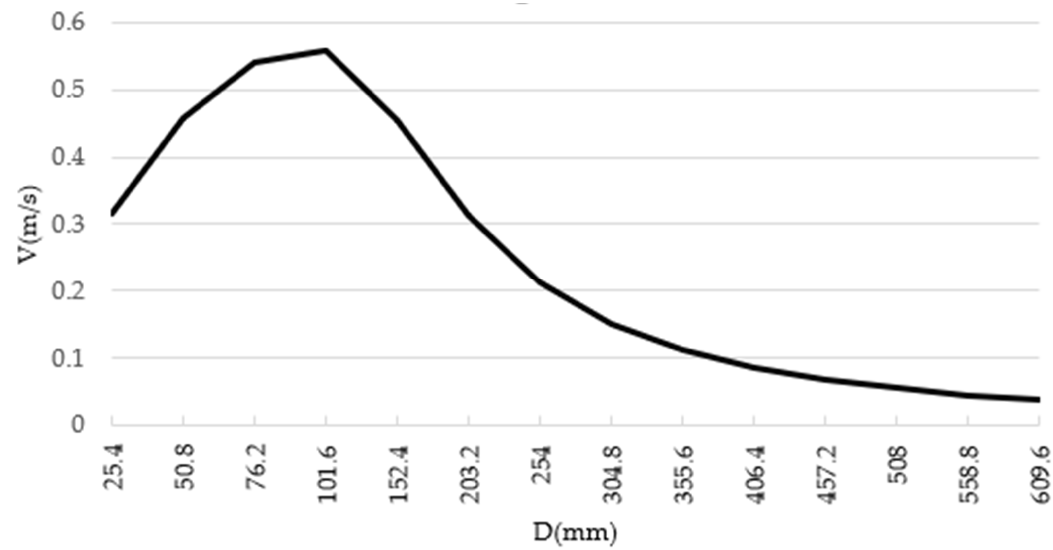
Figure 2. Change in velocity of pipe 8 in the two-loop network.